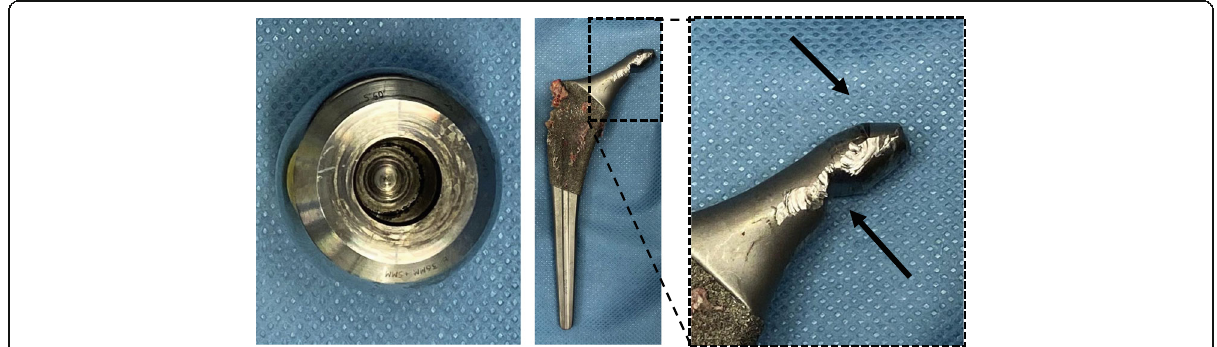
Fig. 4 Photographs of the extracted instrumentation. Left panel: metal debris inside the metal head. Middle and right panels: significant deformation at the head-stem trunnion (arrows)